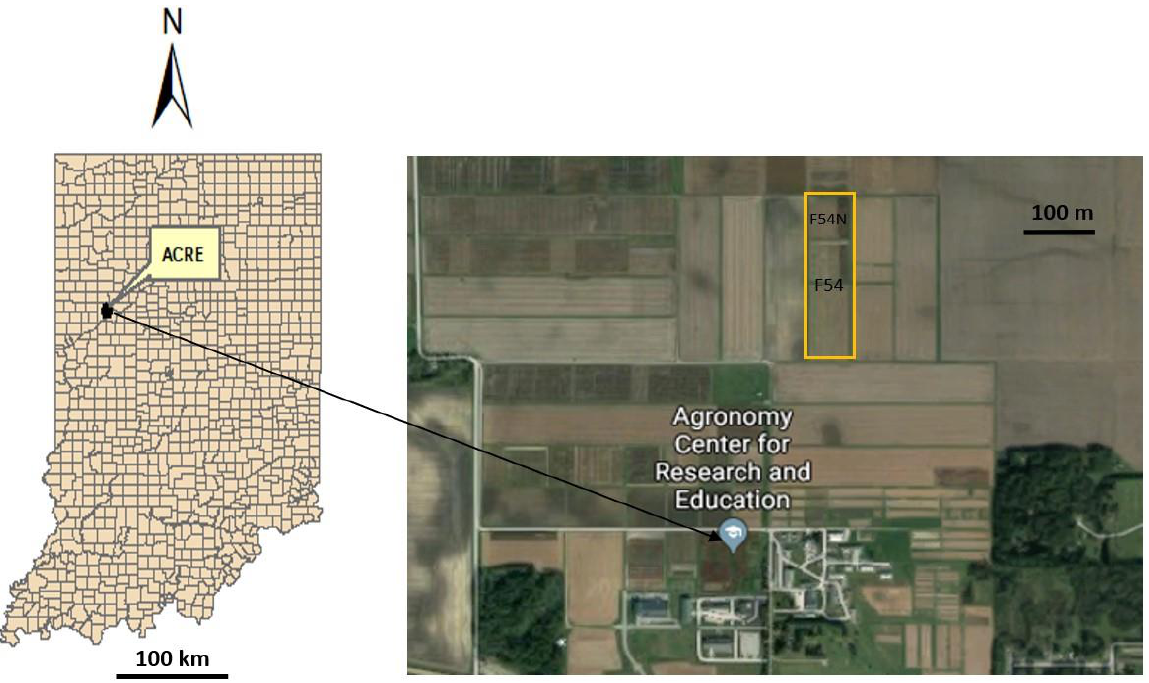
Figure 1. Locations of ACRE and the research field (image acquired from Google Maps).